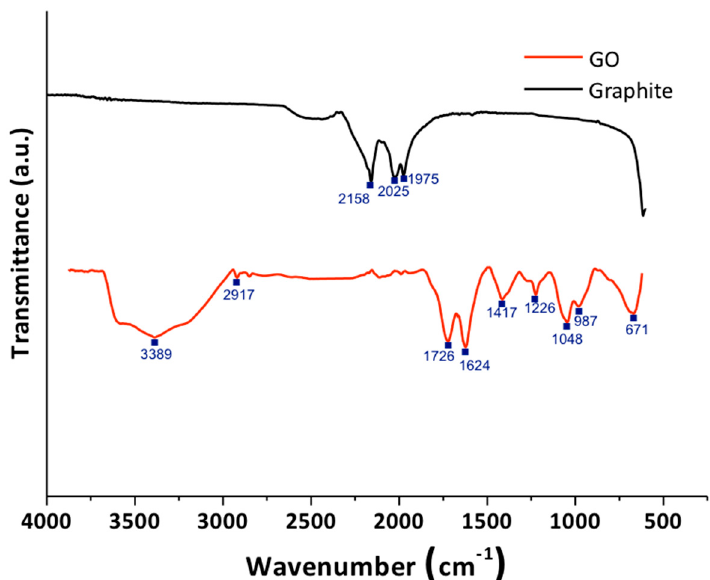
Figure 1. Fourier-transform infrared (FTIR) spectroscopy of graphite (black line) and graphene oxide (GO; red line). a.u.: Arbitrary units.